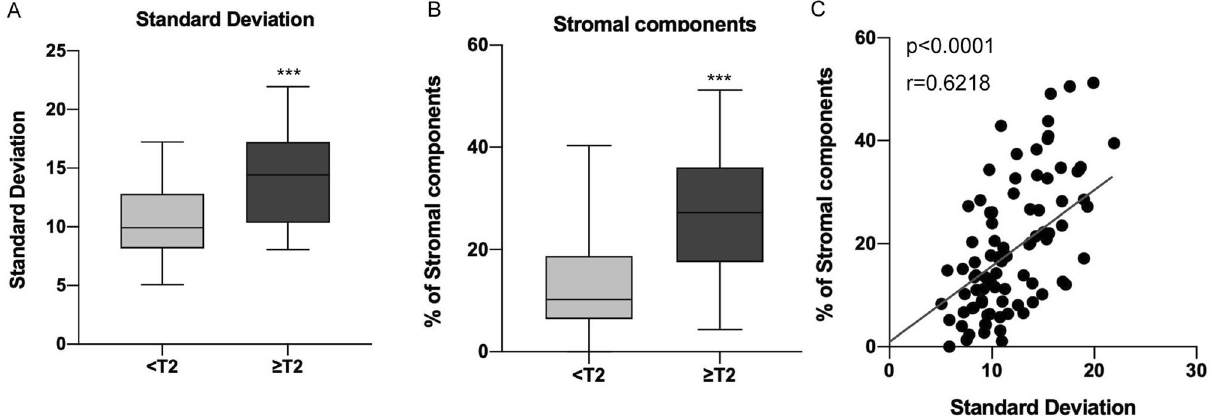
Figure 2. The associations between SD and histological findings. ( A ) Boxplot for SD obtained from TA according to pathological T stage. ( B ) Boxplot for the amount of stromal components according to pathological T stage. ( C ) Scatter plot comparing SD in TA and the amount of stromal components in histology. *** p < 0.0001. SD = standard deviation, TA = texture